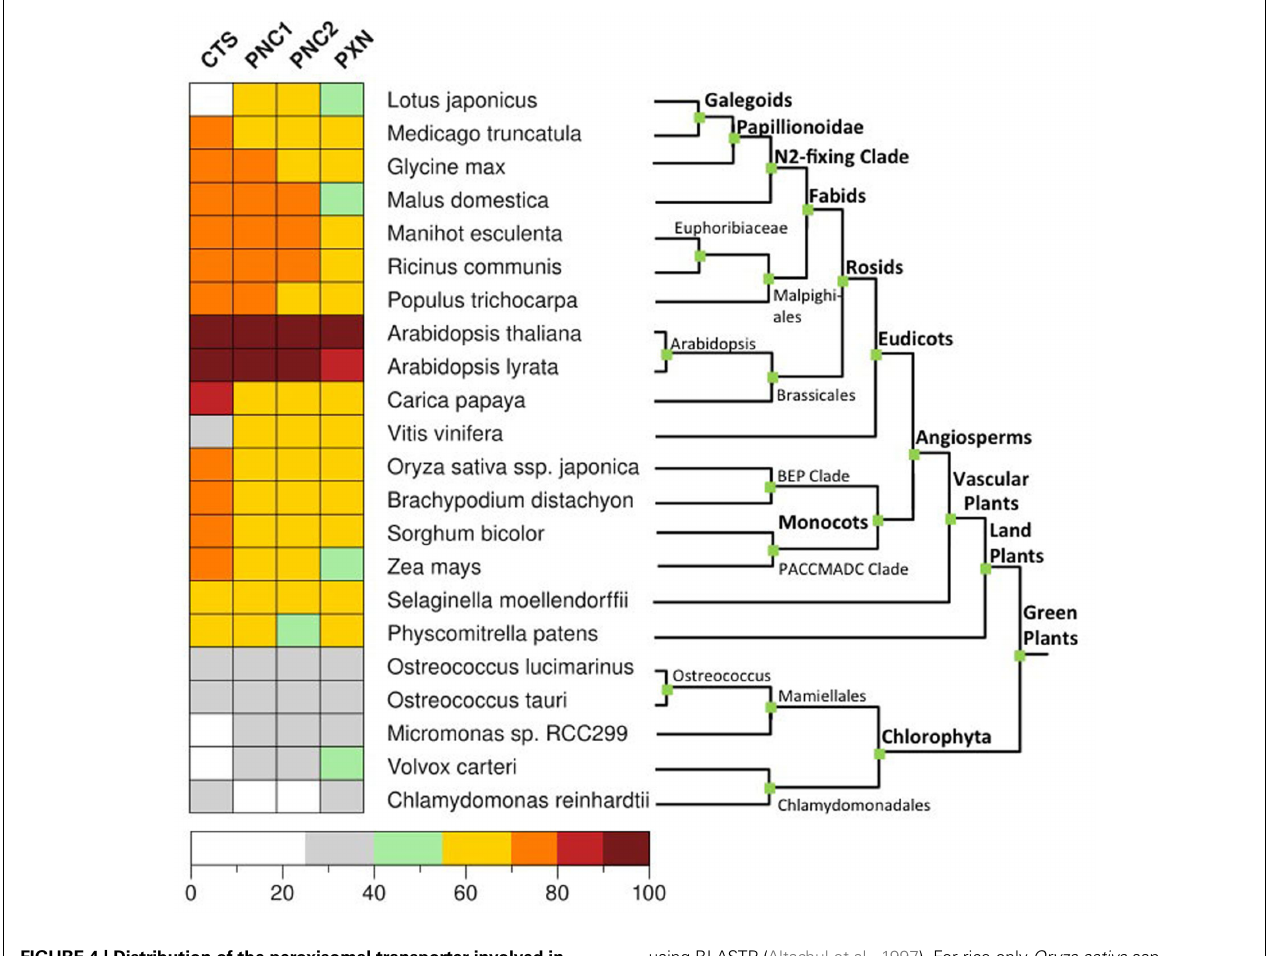
FIGURE 4 | Distribution of the peroxisomal transporter involved in the uptake of fatty acids,ATP, and NAD in green plants. Homologs genes for CTS (At4g39850), PNC1 (At3g05290), PNC2 (At5g27520), and PXN (At2g39970) were identified in 22 fully sequenced plant genomes from PLAZA 2.0 (http://bioinformatics.psb.ugent.be/plaza)